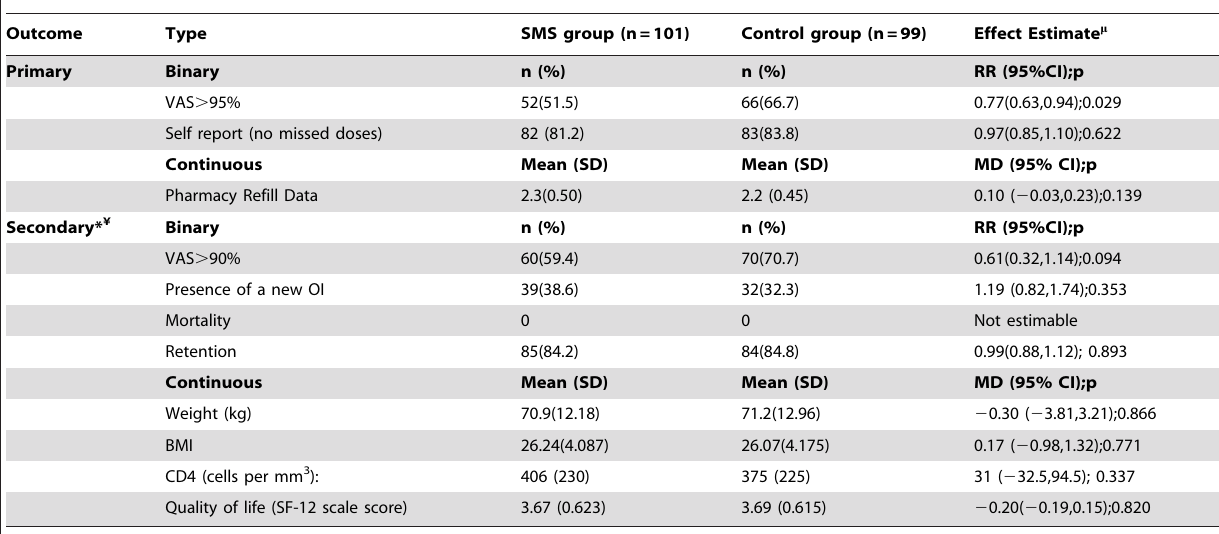
Table 3. Outcomes at 3